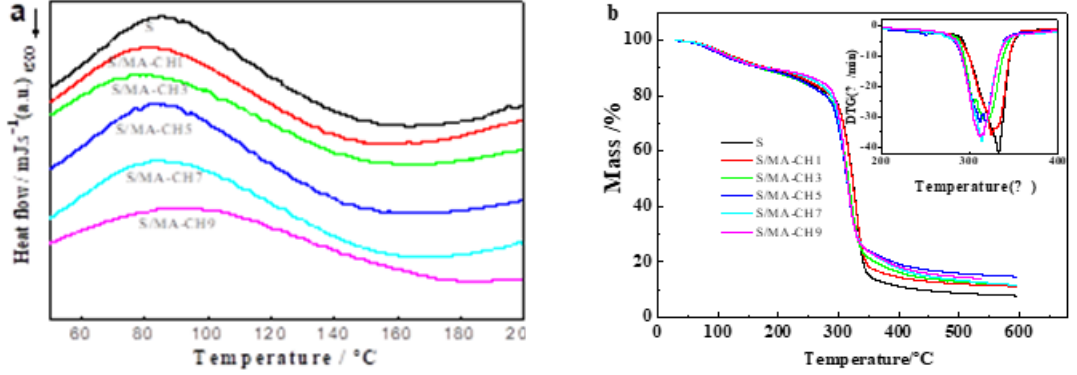
Figure 4. DSC thermograms ( a ) and thermogravimetric (TGA) and derivative thermograms (DTG) ( b ) of S films, S / CH 1% films, S / CH 3% films, S / CH 5% films, S / CH 7% films, S / CH 9%, S / MA-CH 1% films, S / MA-CH 3% films, S / MA-CH 5% films, S / MA-CH 7% films, and S / MA-CH 9% films.